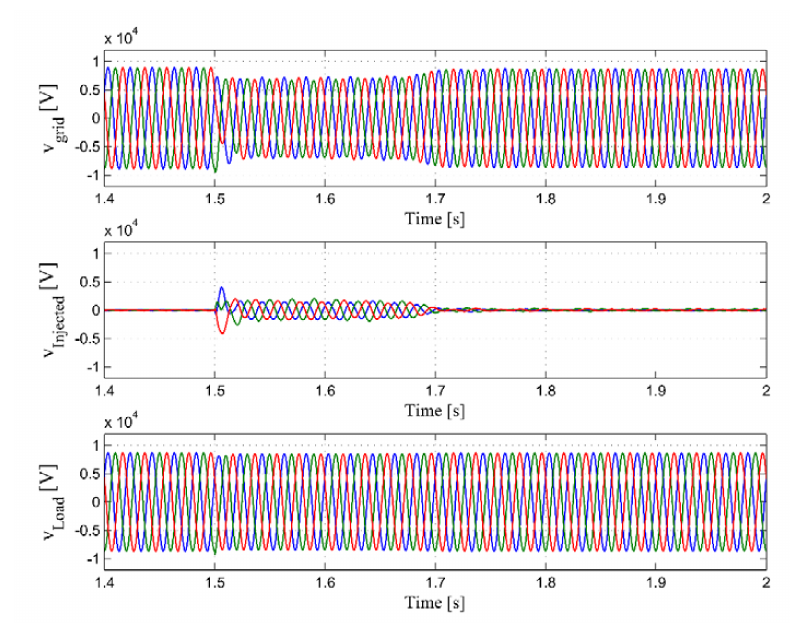
Figure 14. Case 3-Voltage sag due to starting motor: grid voltage, injected voltage of the DVR and load voltage. The load voltage is restored less than 1 / 2